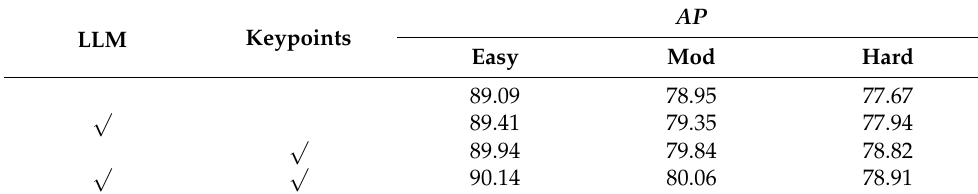
Table 4. AP of different module settings.